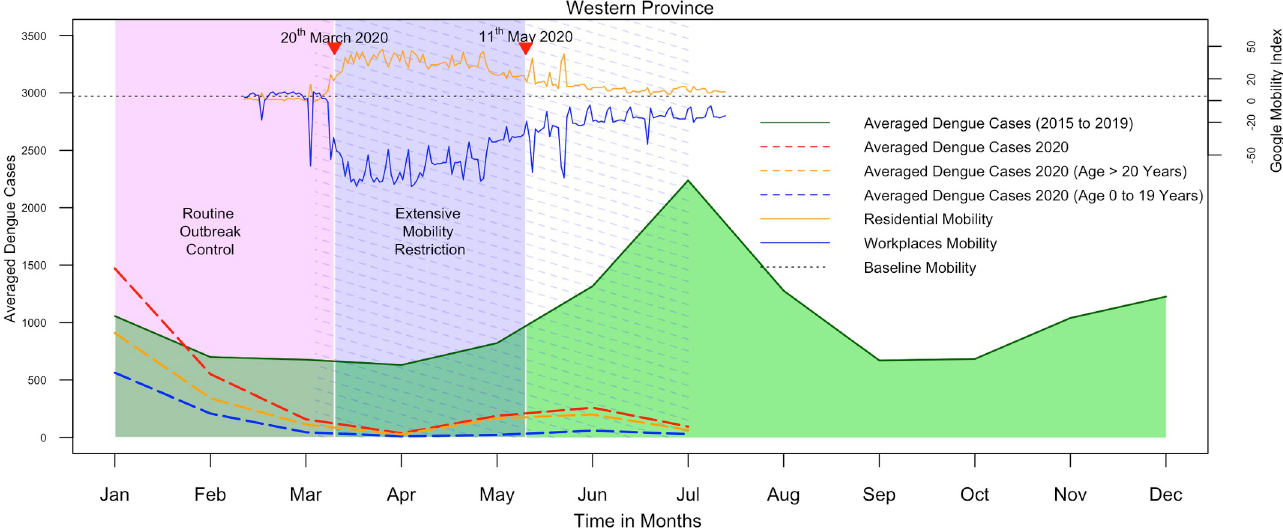
Fig 3. Reported dengue cases among children and adults during 2020 compared to monthly averaged dengue cases reported from 2015 to 2019 averaged across all districts in the western province in Sir Lanka. The green solid line shows the five-year average. Red dashed line shows cases reported during 2020.The blue and orange dashed lines indicate the monthly average number of dengue cases among children (age 0 to 19 years) and adults (age more than 20 years) reported respectively in 2020. The purple solid area indicates the period of extensive mobility restriction; the purple dashed area indicates the period of school closure; the pink area indicates the period of routine dengue outbreak control interventions. The residential mobility represents the percentage change of daily mobility compared to the baseline residential mobility; the workplace mobility represents the percentage change in daily mobility compared to the baseline workplace